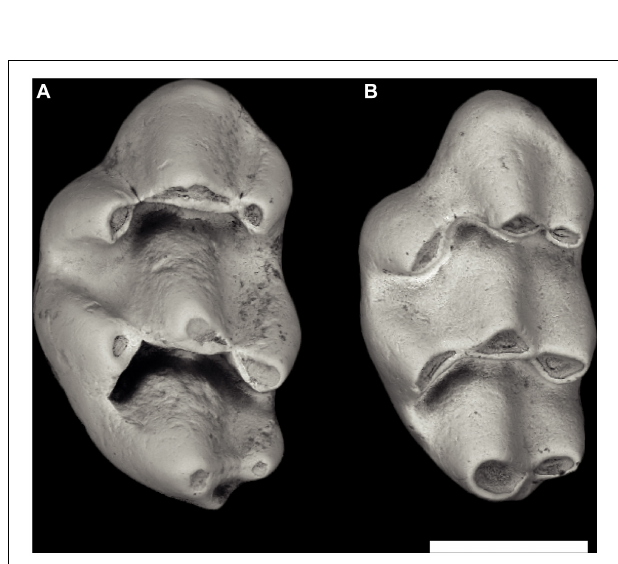
FIGURE 5 | Early Karnimata and Progonomys from locality Y311, 10.1 Ma. (A) Karnimata fejfari left M1 YGSP 54147 and (B) Progonomys hussaini left M1 YGSP 541443. Progonomys is slender with more inclined cusps but is near the size of Karnimata . Both at same 1 mm scale, anterior is upward.